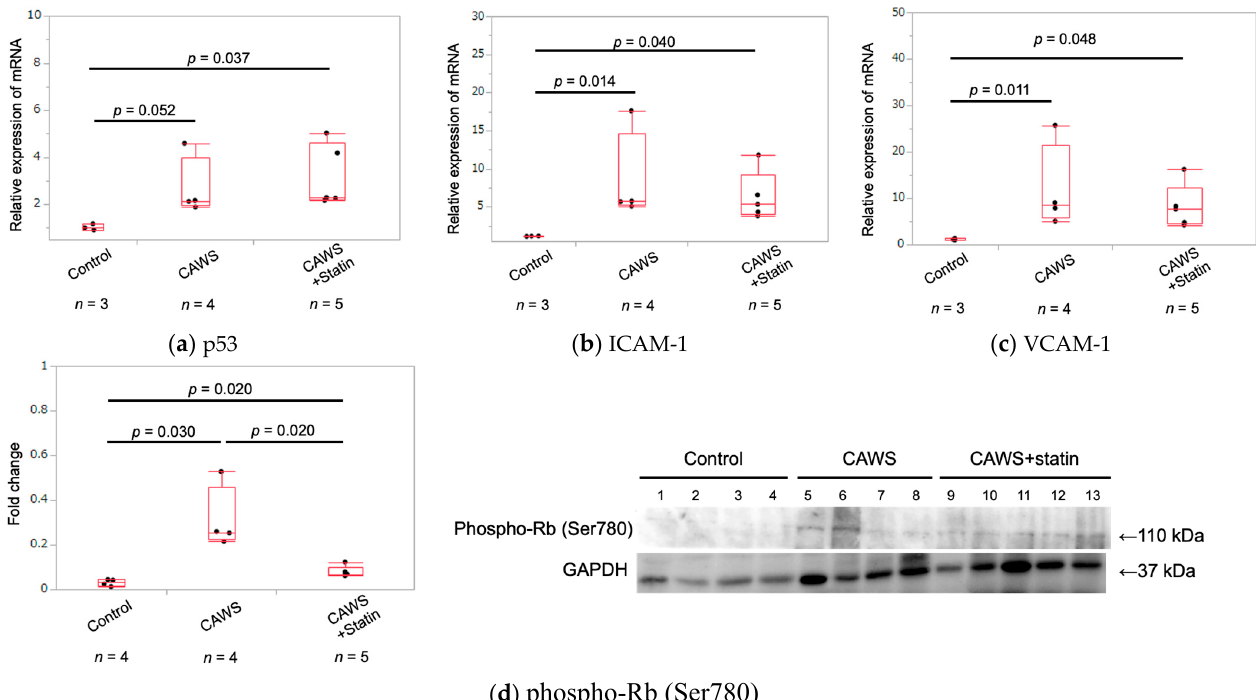
Figure 3. Analysis of mRNA and protein expression in aortic tissue. ( a – c ) The expression of p53, ICAM-1, and VCAM-1 was evaluated. Evidence of progressive cellular senescence in the vessels was observed following CAWS administration. Cellular senescence was not significantly inhibited following treatment with statin. ( d ) Analysis of phospho-Rb (Ser780) protein expression in aortic tissue. Phospho-Rb (Ser780) expression was higher in the CAWS and CAWS+statin groups than in the control group. These findings indicate that CAWS vasculitis causes progressive cellular senescence in vascular tissues, and treatment with statin suppresses this expression.